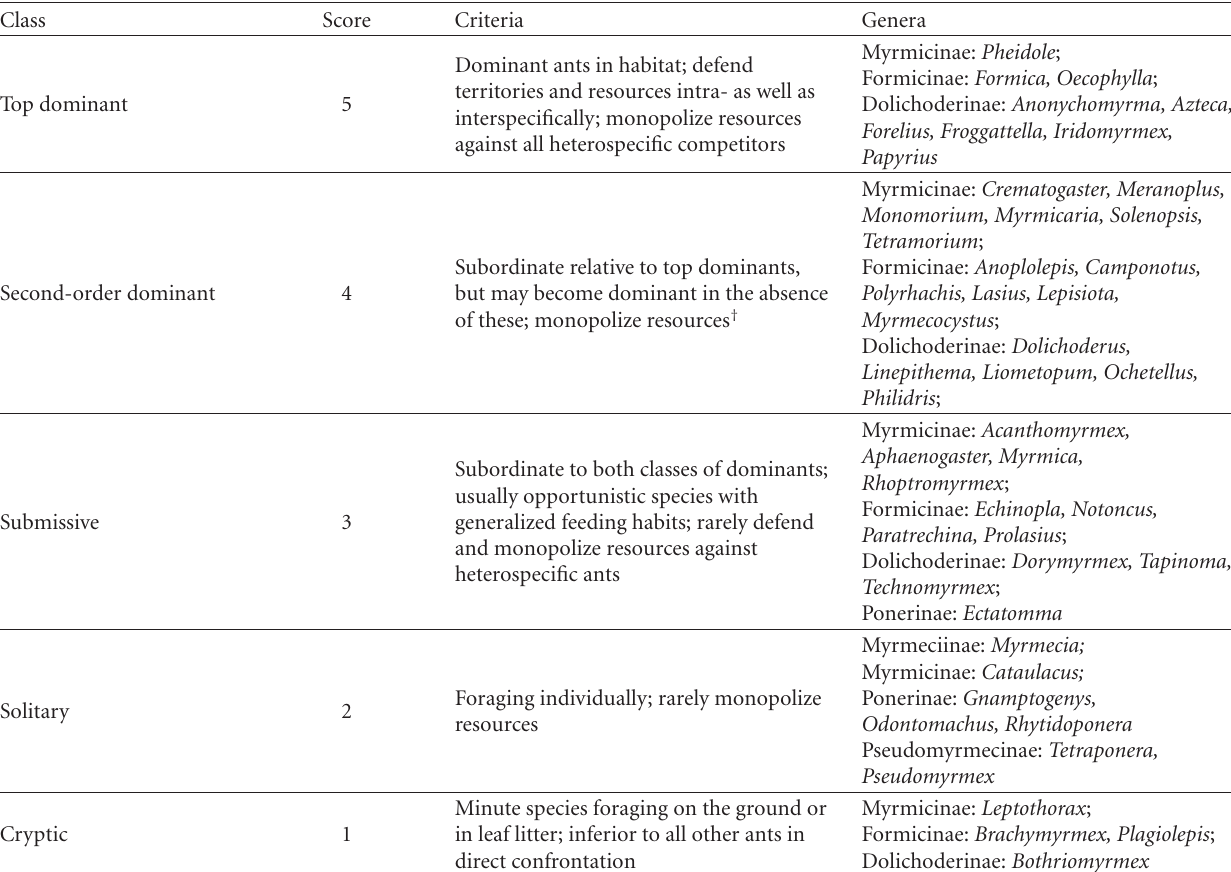
Table 1: Classification of ant genera known to associate with Lycaenidae caterpillars into prevalence groups. Ant genera are classified into that group which corresponds to the dominance status of its most dominant component species involved in butterfly-ant associations. For example, Formica is scored as “top dominant” since many (but not all) Formica species are territorial key-stone ant species in their respective habitats and communities, adapted from [24].